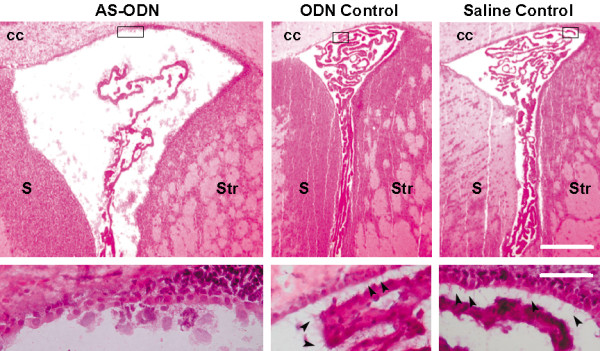
Typical light microscopic view of ipsilateral ventricles. Hematoxylin-eosin staining of coronal brain sections illustrates damaged, irregular and ruptured structure of the ependymal cell layer in AS-ODN (antisense-oligodeoxynucleotide against Gαi2) treated animals. Numerous dying cell populations float inside the ventricle and scarcely any cilia are present. The ependymal cell layer of ODN control (nonsense oligodeoxynucleotide) and saline control animals show a normal, uniform ependymal cell row with numerous cilia (arrowheads). Scale bar: upper images, 500 μm; lower images, 50 μm. cc: corpus callosum, S: septum, Str: striatum.